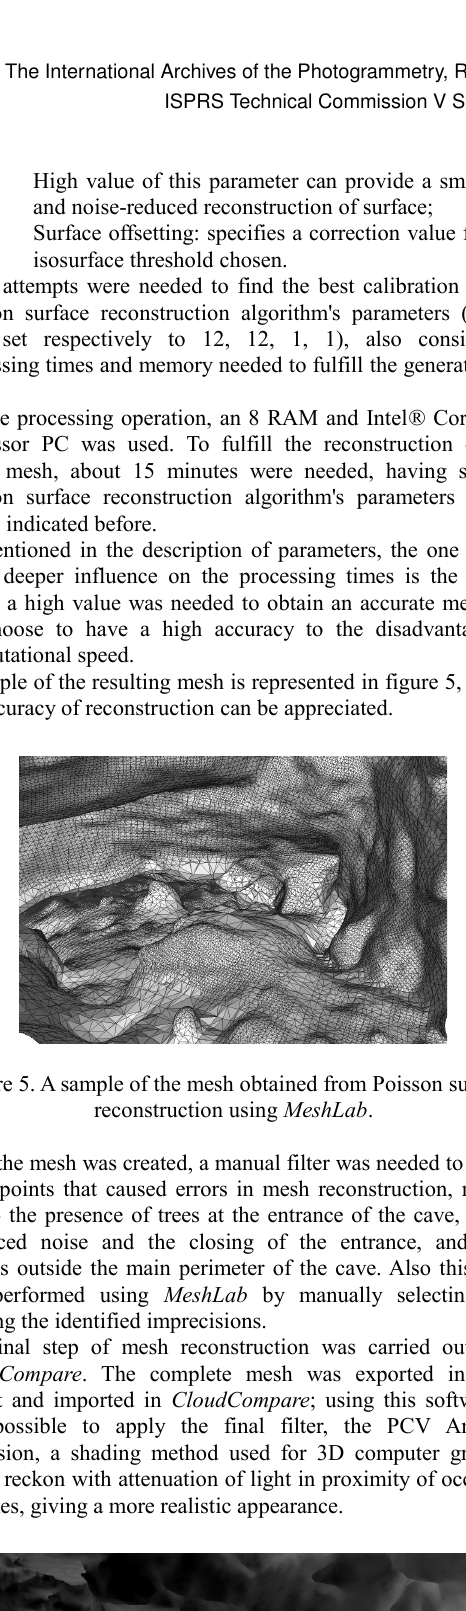
Figure 8. Horizontal sections extracted with CloudCompare